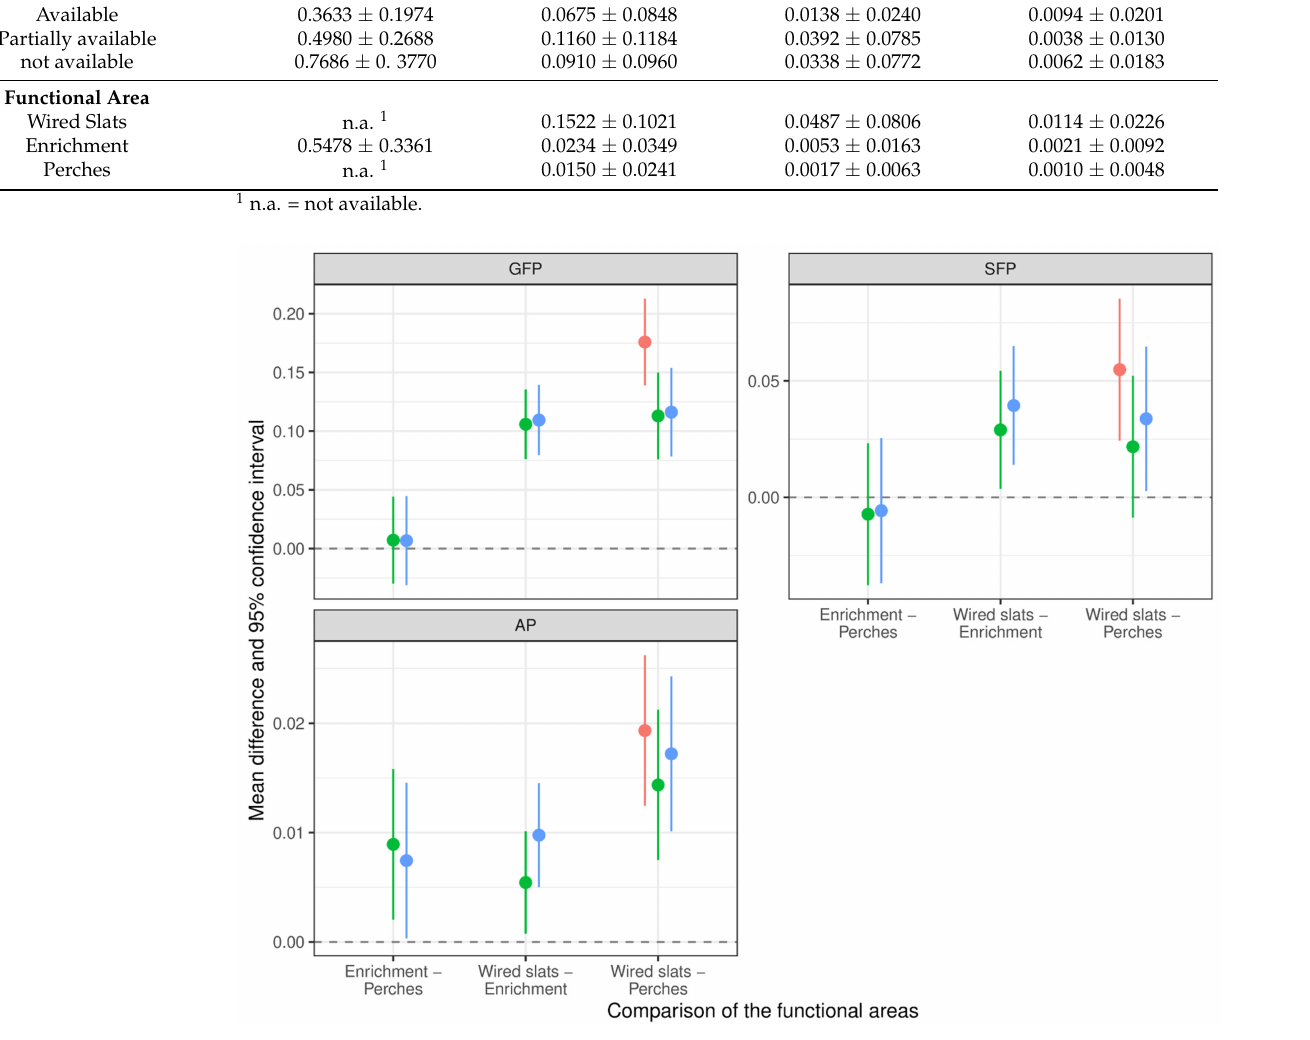
Figure 3. Mean differences of functional areas on the occurrence of pecking. The diagram shows the mean differences and the 95% confidence interval (CI) of observed functional areas on the occurrence of gentle feather pecking (GFP), severe feather pecking (SFP), and aggressive pecking (AP). Results were considered significant when the CI did not include zero. Estimated effects above zero indicate an increase in the chance of observing a behavioral parameter, whereas estimated effects below zero indicate a decrease. Red = NE (not enriched, high stocking rate), green = EL (enriched, low stocking rate), blue = EH (enriched, high stocking